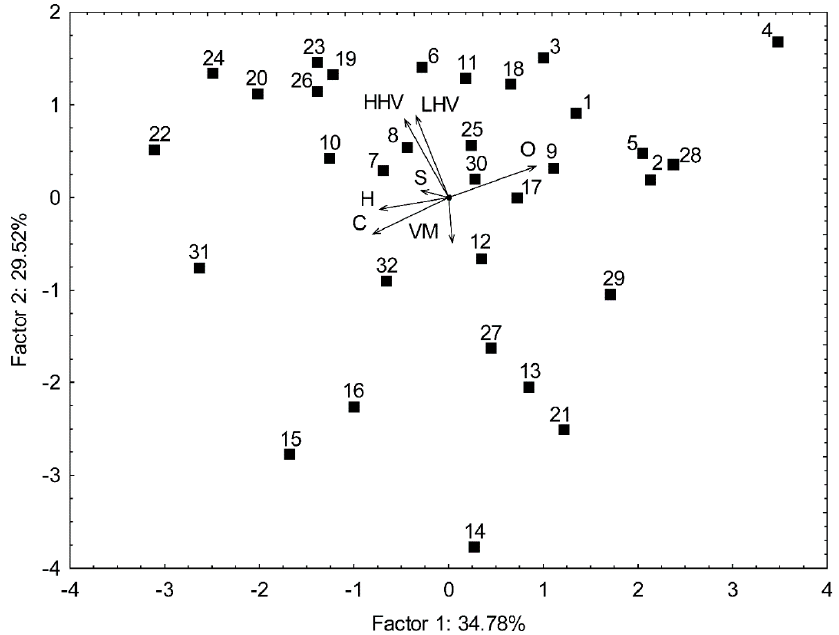
Figure 1. Principal component analysis (PCA) of observed samples depending on the year, drying temperature, and duration.